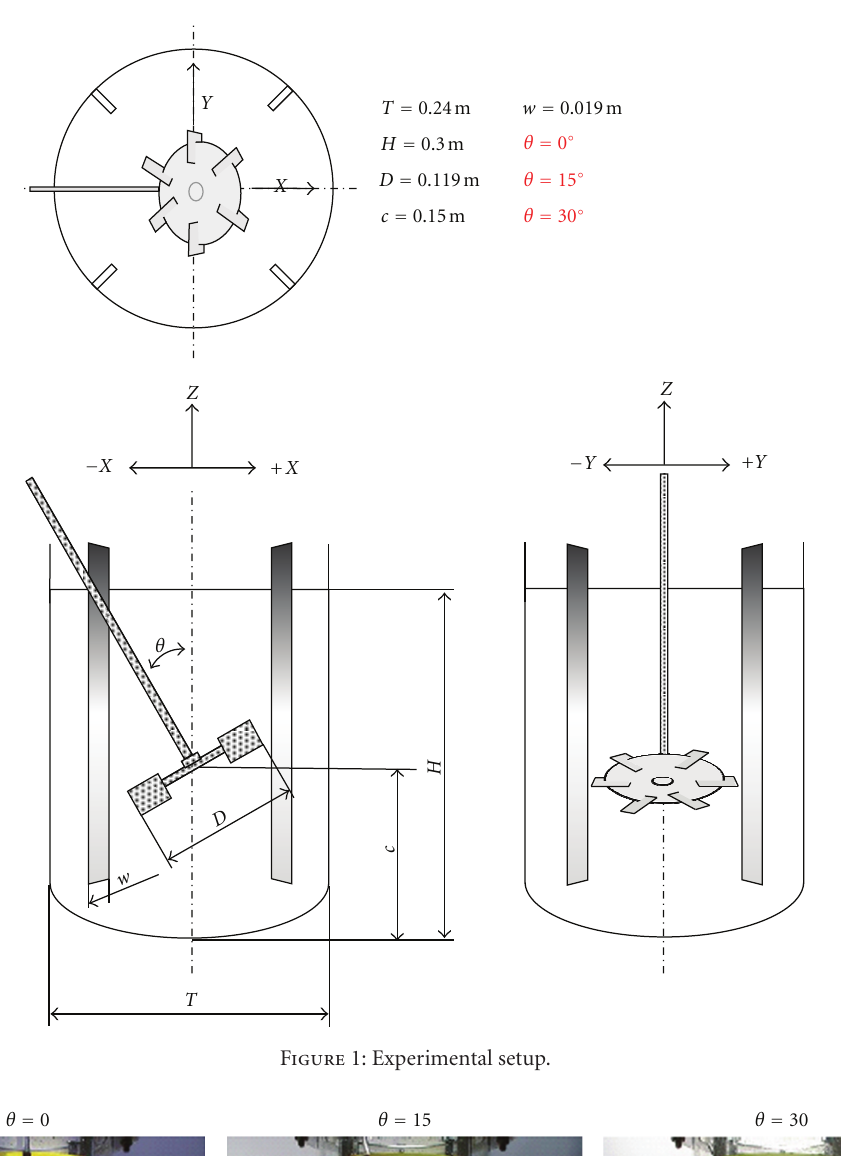
Figure 1: Experimental setup.